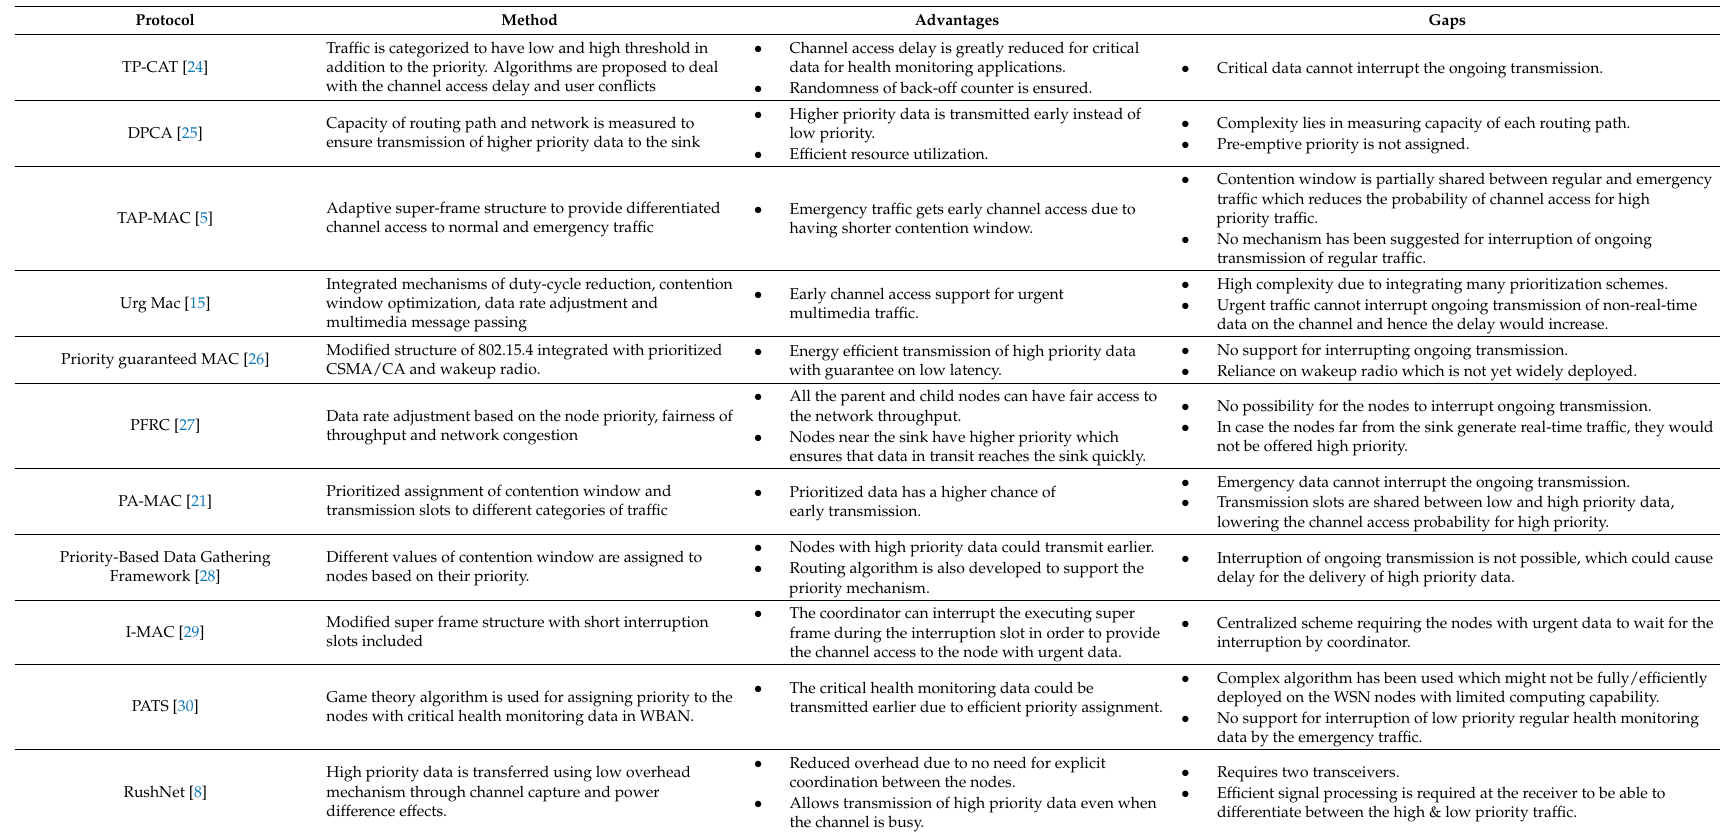
Table 1. Review of Priority MAC Mechanisms for